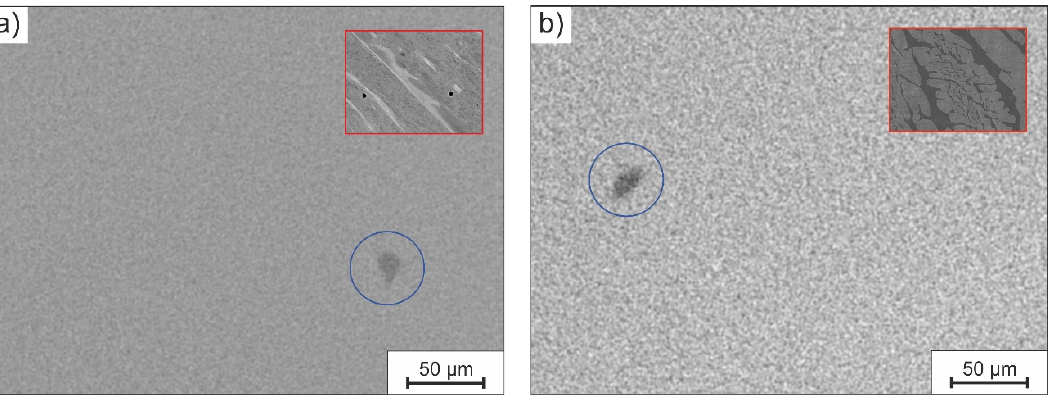
Figure 8. CT slices of the steels: ( a ) X2CrNiW15-9-5; ( b ) X2CrNiSi18-9-4. Blue circles highlight the non-metallic inclusions. The red boxes contain SEM images of each steel’s microstructure for comparison.